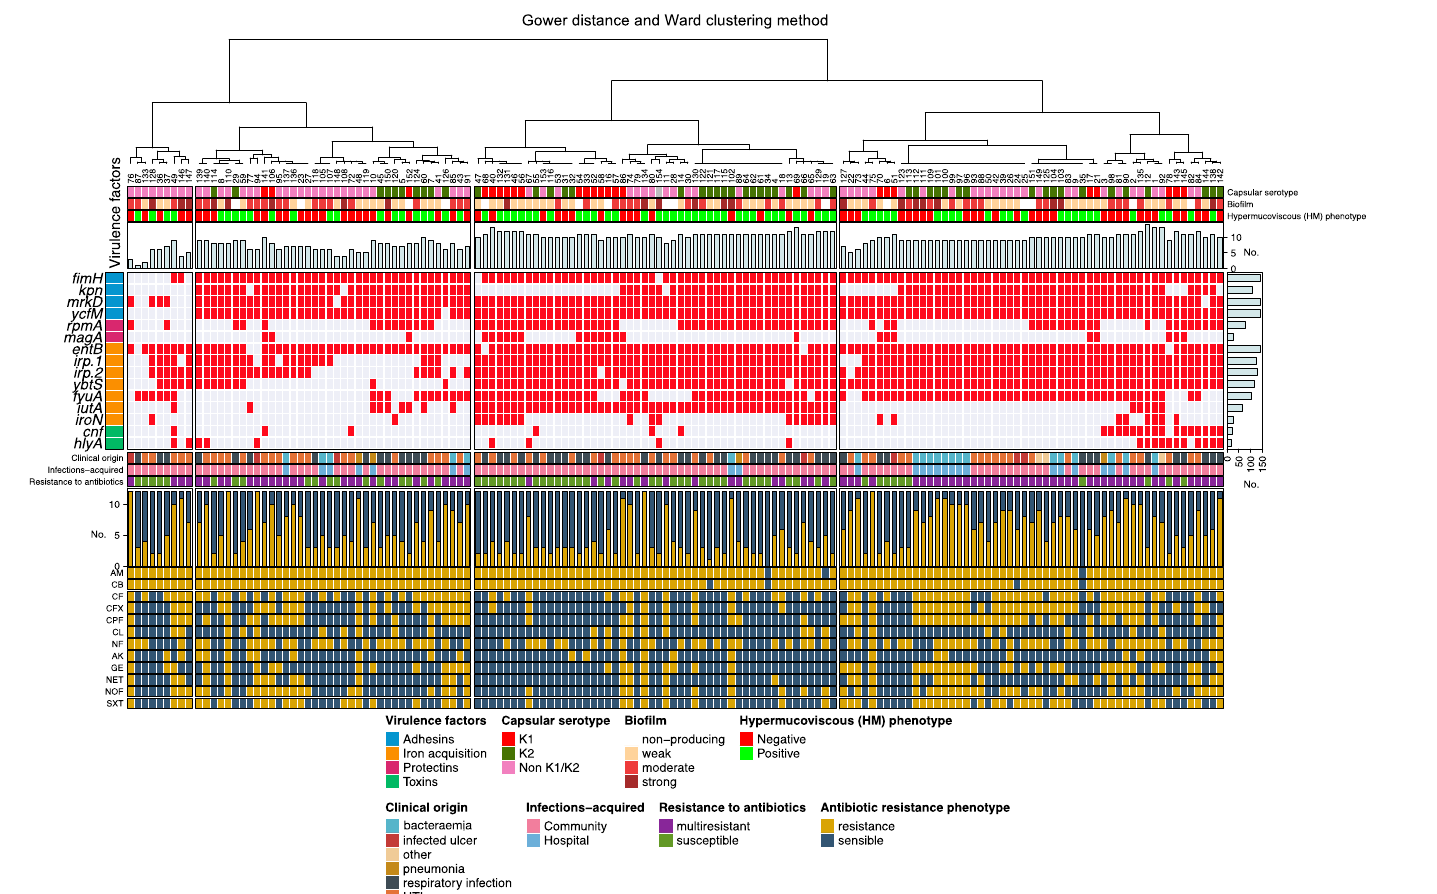
Figure 1. Clustering of K. pneumoniae strains according to virulence genotype profile and its association with clinical origin from patients with hospital- and community-acquired infections, capsular serotype, biofilm formation, hypermucoviscous phenotype, and antibiotic resistance. Positivity and negativity for a given genotype is represented by a red and grey rectangle, respectively. Cladograms of the strains are shown at the top. Upper axis: identification number of the strains. Upper left axis: virulence genes. Lower left axis: antibiotic resistance (resistance to a given antibiotic is represented in yellow and susceptibility in blue). Upper bars (grey): frequency of the different virulence genes detected in each strain. Right bars (grey): frequency of each virulence gene. Lower bars (yellow): frequency of antibiotic resistance detected in each strain. Other: stool culture ( n = 2) and tumor biopsy ( n = 1).